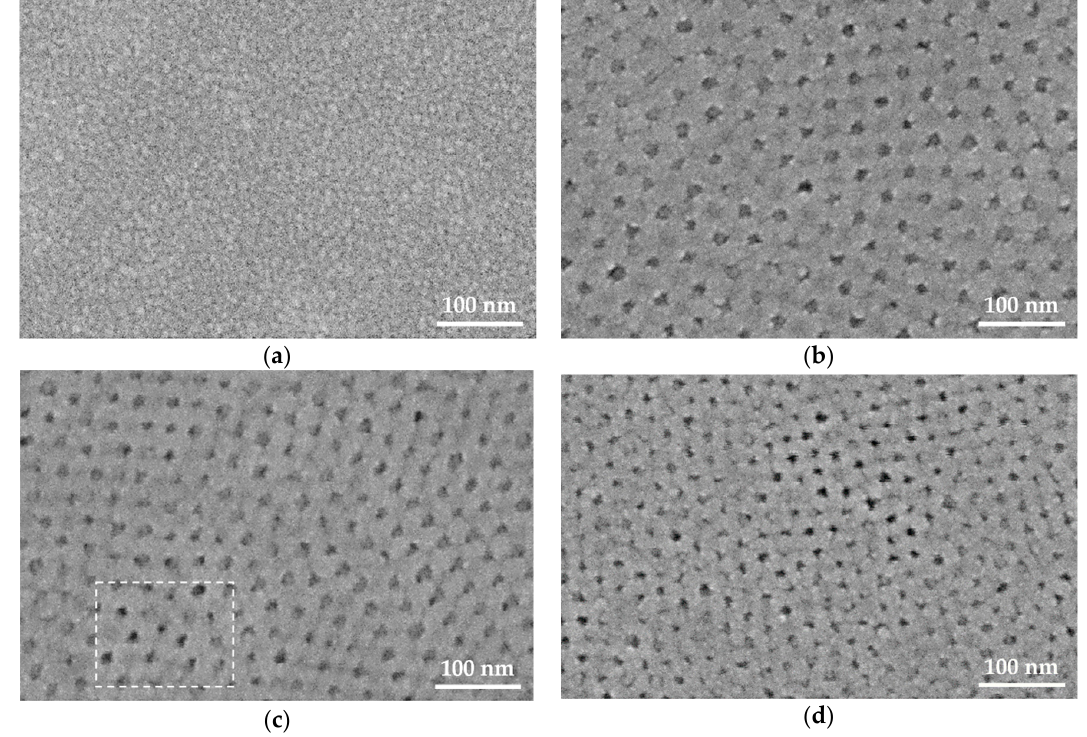
Figure 2. Top-view SEM images of the ( a ) Ti-0, ( b ) Ti-6, ( c ) Ti-12, and ( d ) Ti-21 thin films made on FTO substrates. The dark spherical features indicate pore openings, while the brighter areas represent the surrounding TiO 2 wall structure (see text for further details).